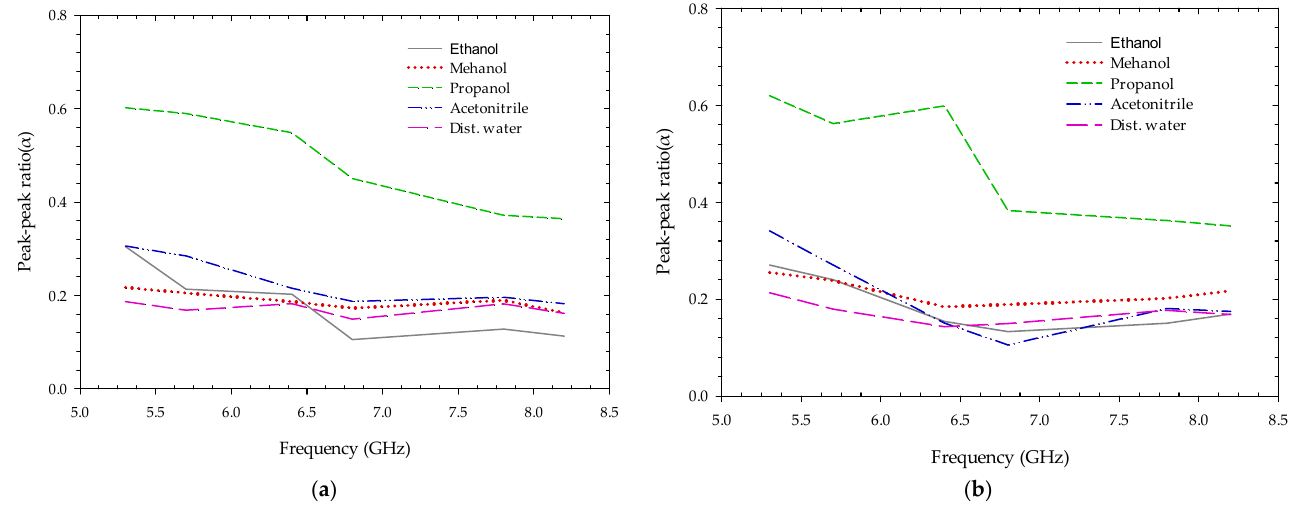
Figure 12. The ratio of peak-to-peak voltage level with and without fluid MUT at different transmitted impulse frequency transmission trough using ( a ) podal antenna; ( b ) antipodal antenna. Similarly, delay in a sample obtained from cross-correlation between the two-sample frames of MUT and without MUT are plotted in Figure 13. Because higher frequency signals attenuate faster than lower frequency signals, the signal-to-noise ratio is very low at higher frequencies, losses in the connecting cables, as well as parasitic effects on the soldered area around the SMA connector, affecting the measurement and delay of the samples. Figure 14 depict the resistivity or viscosity due to MUT on electromagnetic wave transmitted at different impulse frequencies using Equation (10). From the plot, we can see the electromagnetic wave interacting differently for each fluid sample, which may be used to forecast the nature of the fluid and its behavior for different transmission frequencies.